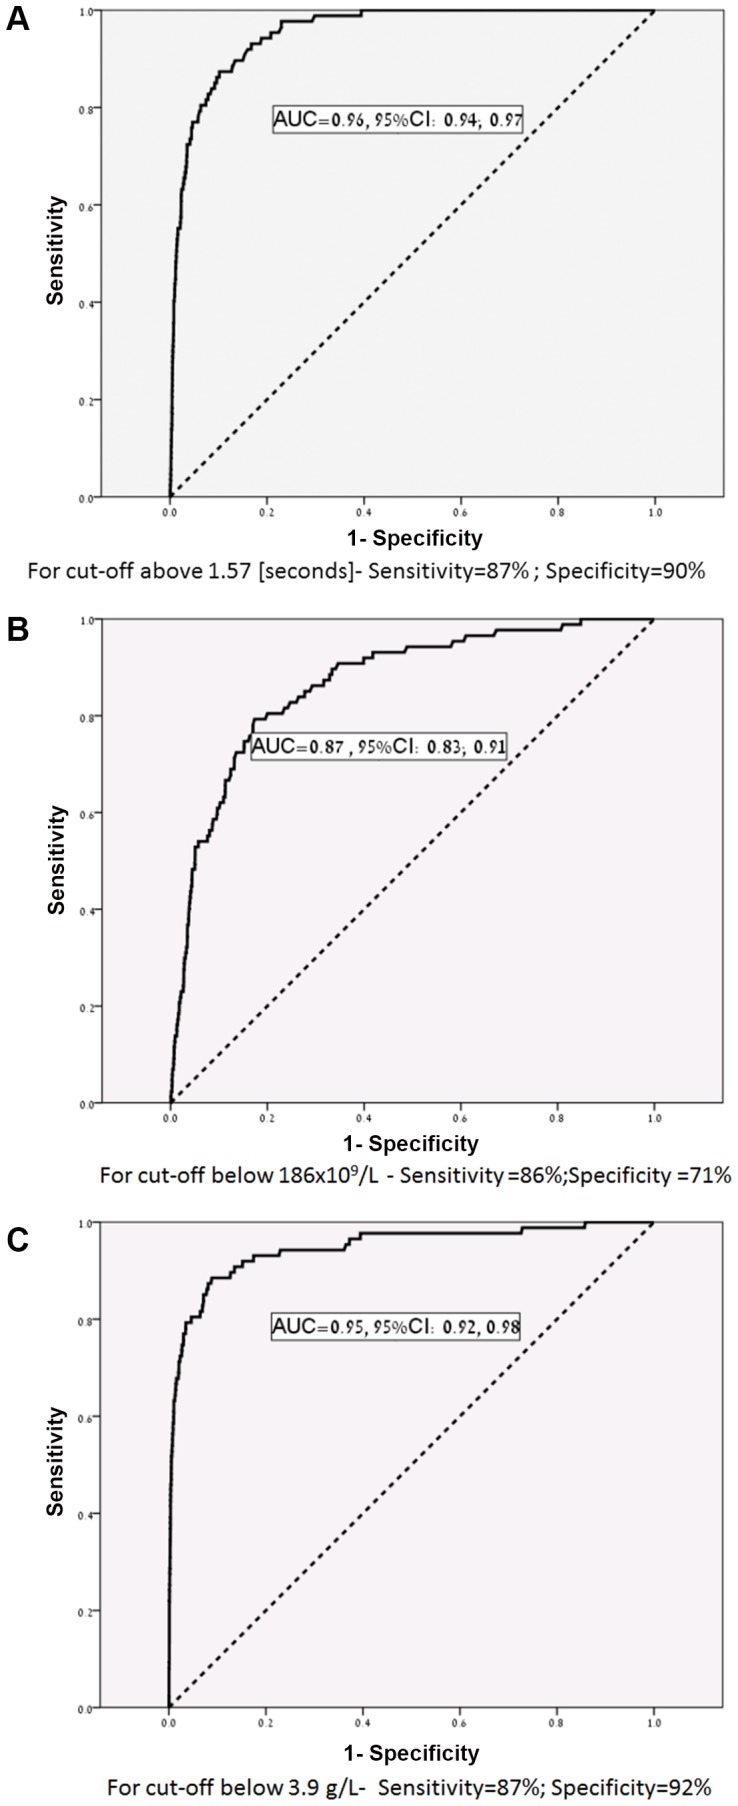
ROC curve analysis for the association of the major components of the pregnancy modified DIC score: a)- PT- difference; b)- platelets; and c)- fibrinogen, with the development of DIC.